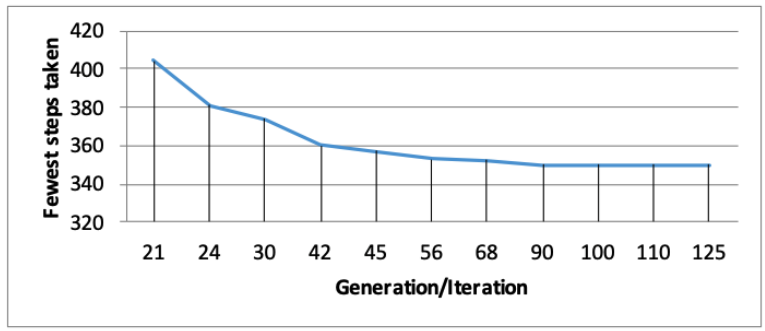
Figure 7: Graph representing the fewest steps taken by the